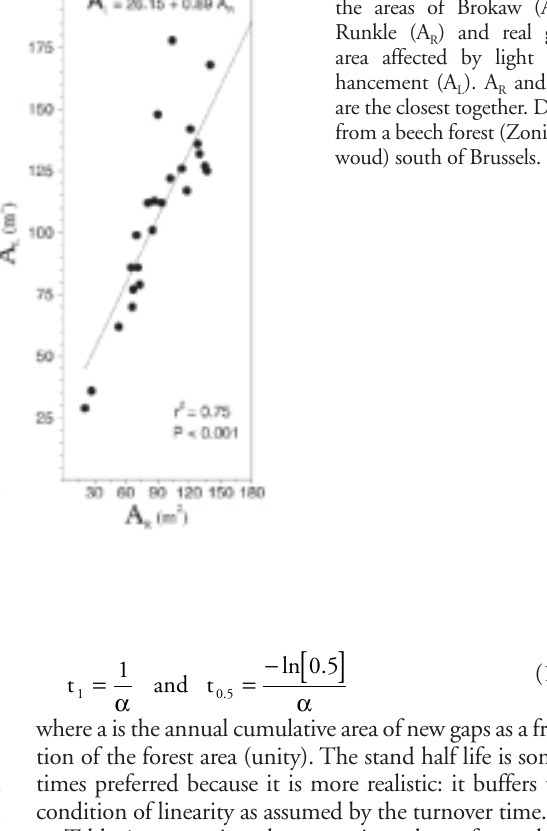
) and stand half life (t 1